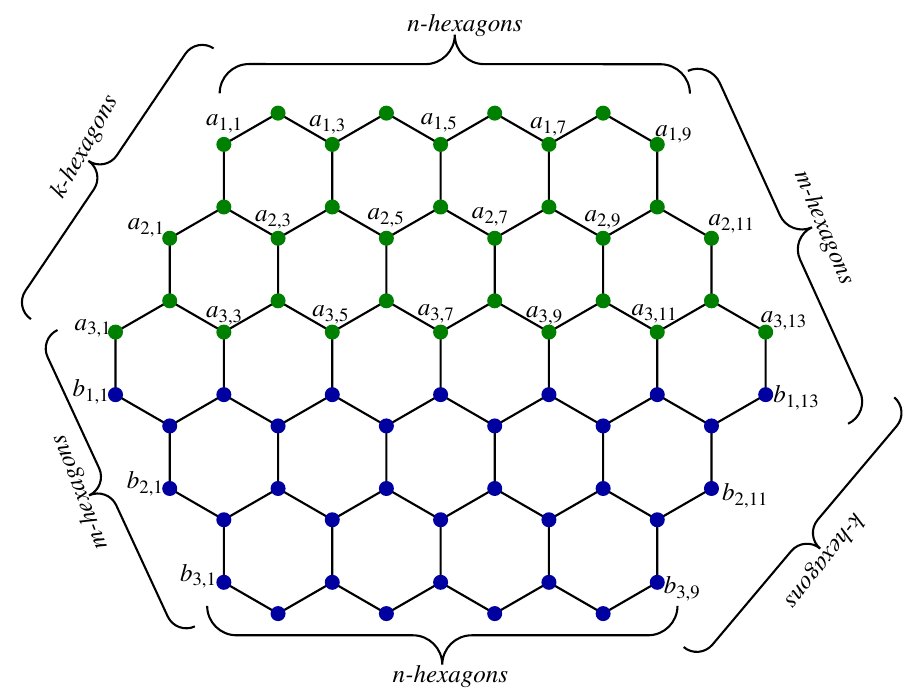
Figure 1. Generalized Hexagonal Cellular Network with m = 3 = k , n =